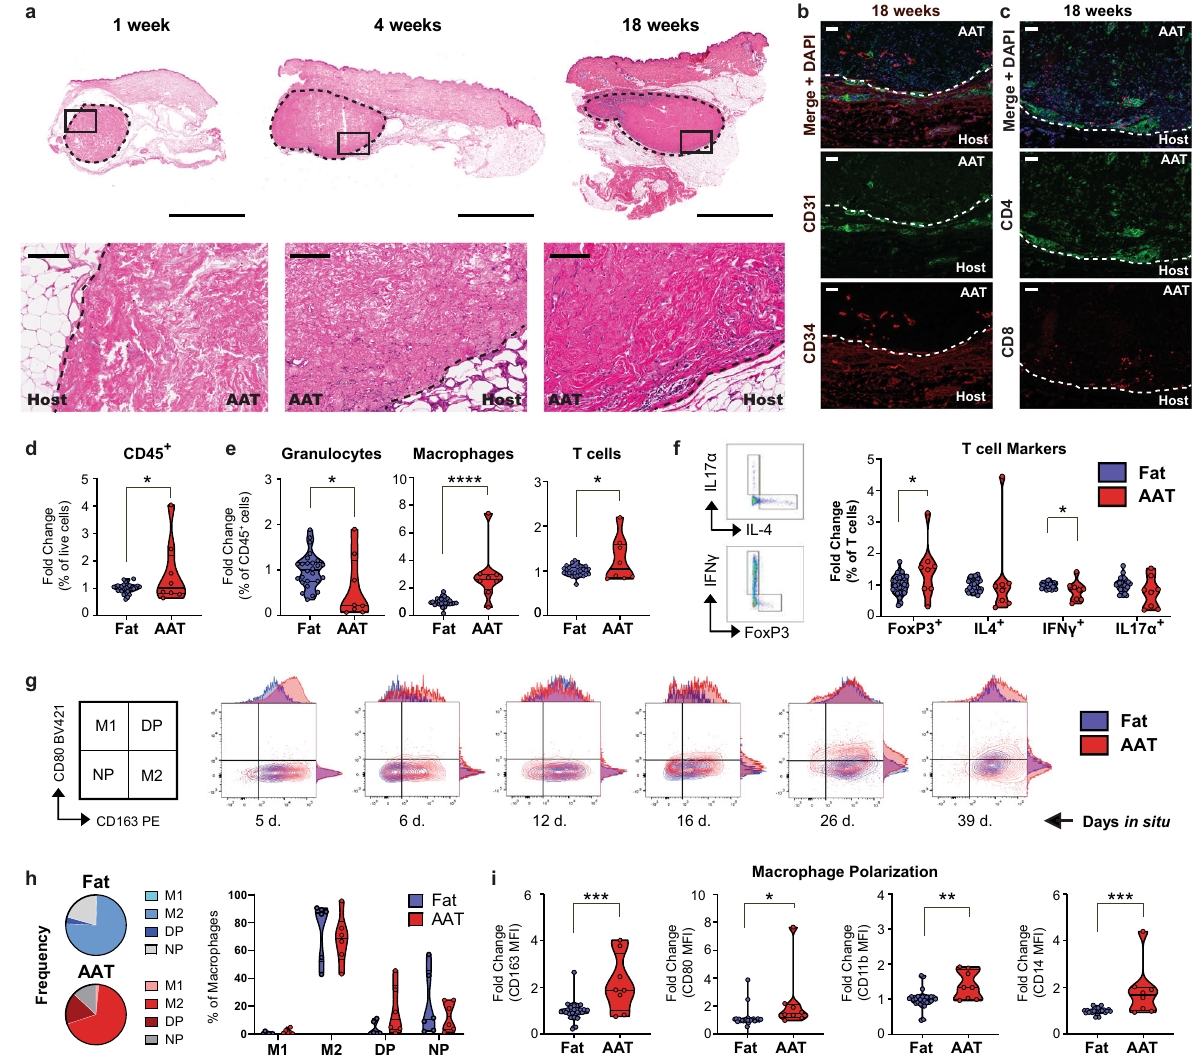
Fig. 6 Subcutaneous injection of AAT in healthy volunteers. a H&E staining of AAT implants excised from healthy volunteers at early, mid, and late timepoints during a fi rst-in-human Phase 1 study. High magni fi cation insets show cell migration from the adjacent host tissue into the AAT matrix. b Multispectral immunohistochemistry (IHC) reveals formation of blood vessels (CD31 + ) and migration of adipose stem cells (CD34 + ). c CD4 + and CD8 + T cell in fi ltration by multispectral IHC. d Flow cytometry analysis was performed on excised AAT implants from six subjects to quantify immune cells (CD45 + ) recruited within AAT implant(s) relative to multiple samples of subject-matched adipose tissue collected distally from the injection site. Results for each recovered AAT implant were normalized to the average of multiple samples of subject-matched adipose tissue. Data are shown pooled for all subjects. e Relative abundance of different immune cell subsets including granulocytes (CD45 + CD11b + CD15 + ), macrophages (CD45 + CD15 − CD11c + MHCII + CD11b + CD14 + CD68 + ), and T cells (CD45 + CD3 + ). Data are shown pooled for all subjects. f Relative expression of intracellular FoxP3 as well as T H 1, T H 2, and T H 17 cytokines in T cells isolated from AAT and matched adipose tissue, shown pooled for all subjects. g Expression of macrophage polarization markers (CD163 and CD80) in AAT and matched adipose tissue. ( h ) Average distribution of M1 (CD80 + CD163 − ), M2 (CD163 + CD80 − ), double-positive and nonpolarized macrophages in AAT and matched adipose tissue as a frequency of total macrophages. i Expression of macrophage polarization (CD163, CD80) and lineage markers (CD11b, CD14) by MFI, pooled for all subjects. Signi fi cance ( p -values): * < 0.05, ** < 0.01, *** < 0.001, **** < 0.0001. Median and quartiles are shown in violin plots. Scale bars represent 5 mm in whole sections and 200 µm in enlarged (Supplementary Figs. 8 – 9). Immune populations present inside vessels at the edge of the implant (CD31 + vascular endothelial and around the AAT implants were quanti fi ed relative to multiple cells) and in fi ltration of perivascular/adipose stem cells (CD34 + ) subject-matched normal adjacent adipose samples also collected both around and within the implant at 18-weeks post-injection at the time of implant excision (Fig. 6d – i). CD45 + immune cells (as (Fig. 6b). By this latest excision time point, CD4 + T cells dominated within the scaffold-recruited T cell population (Fig. 6c). Although a percentage of the total live cells) varied by subject but were both CD4 + and CD8 + T cells were found dispersed individually generally enriched within the AAT scaffold compared to local fat (Fig. 6d). Within the CD45 + immune compartment, granulocytes throughout the implant, they also often formed clusters with other non-T immune cells which resembled small tertiary lymphoid (CD45 + CD11b + CD15 + ) were typically less abundant within AAT structures (Supplementary Fig. 7). implants relative to normal fat, while macrophages and T cells Flow cytometry was performed on tissue samples from six study were signi fi cantly enriched in AAT (Fig. 6e). FoxP3 + T cells participants with excision timepoints between 1 and 6 weeks increased within implants, representing recruitment of regulatory